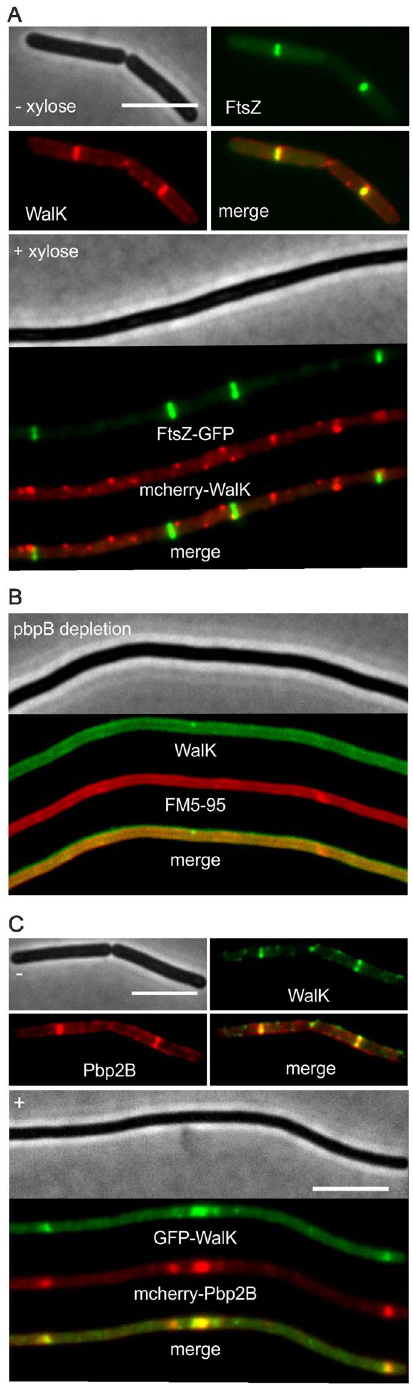
Figure 7. SepF overexpression and pbpB depletion delocalize WalK. ( A ) Microscopic images of strain GYQ571 ( amyE:: P xyl-sepF ftsZ-gfp aprE:: P spac-mcherry-walK ) expressing both FtsZ-GFP and mCherry-WalK, grown without or with 1% xylose to induce SepF overexpression. Additional images shown in Fig. S7. ( B ) Septum- localization of WalK is abolished in cells depted for pbpB (strain GYQ174, pbpB:: P spac-pbpB amyE:: P xyl-gfp- walK ). Membranes were stained with FM5-95. Scale bar is 5 µ